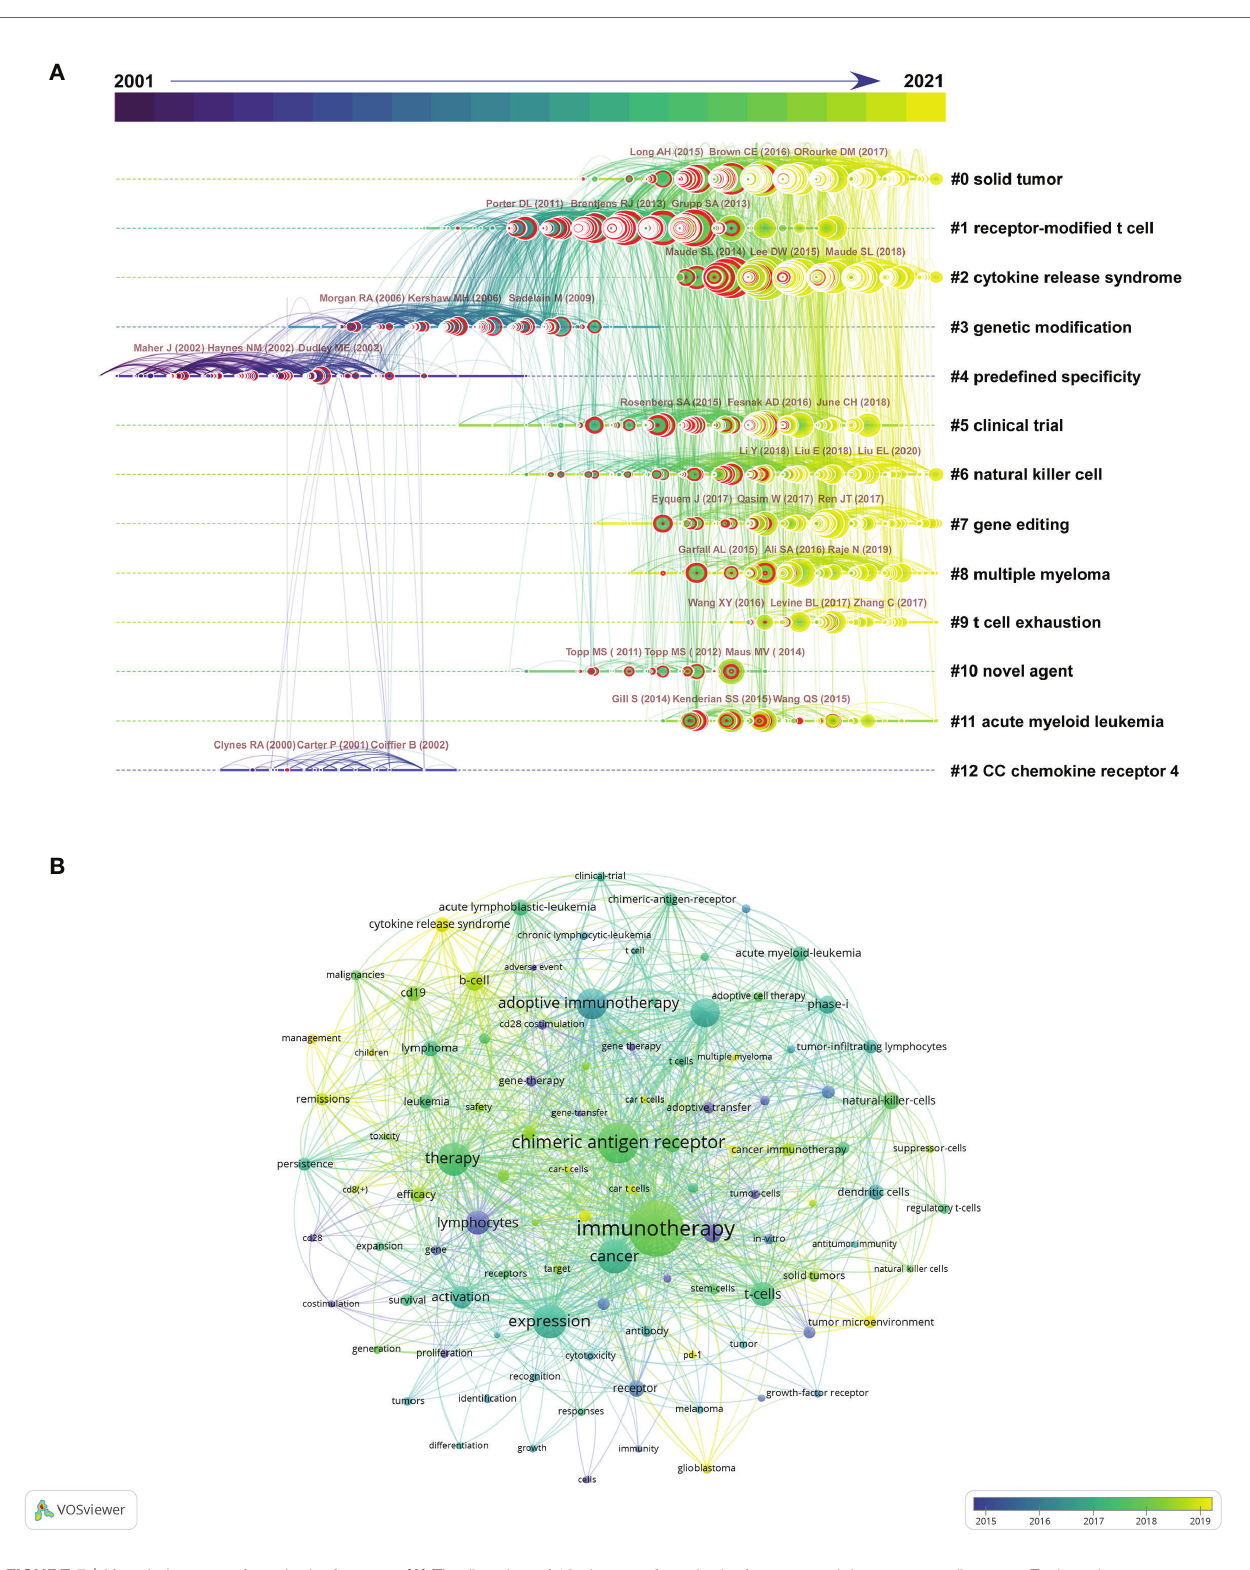
FIGURE 5 | Knowledge map of co-cited references. (A) Timeline view of 13 clusters of co-cited references and the corresponding tags. Each node represents an article or review, and the red circle around the node represents a reference burst. Each line represents a link between two studies. The top 3 co-cited references of each cluster are also displayed above the nodes. (B) The time-overlay network map of the top 100 co-occurring